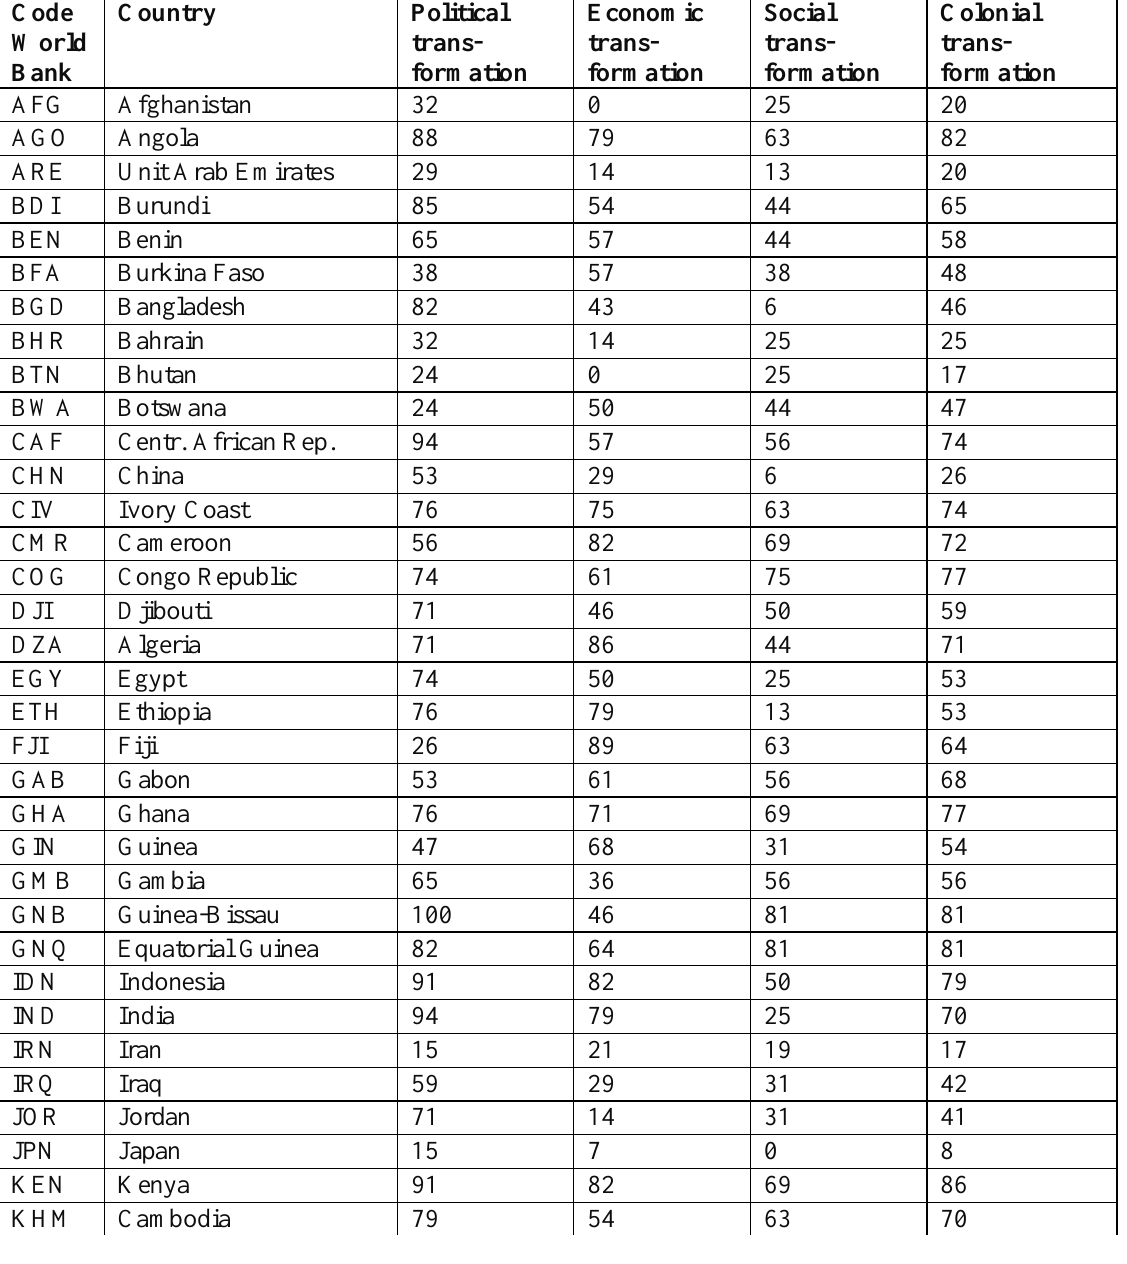
Table 2. Indices of Colonial Transformation – Country